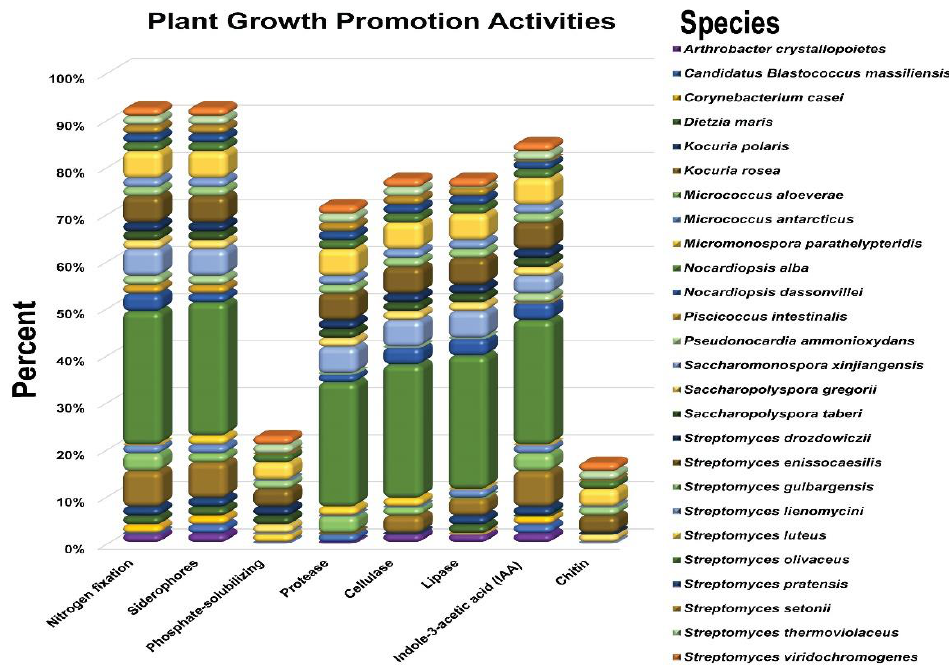
Figure 1. Plant growth-promotion traits of endophytic actinobacteria species from herbal medicinal plant Thymus roseus in vitro. All experiments were performed twice with three replicates for each individual strain.